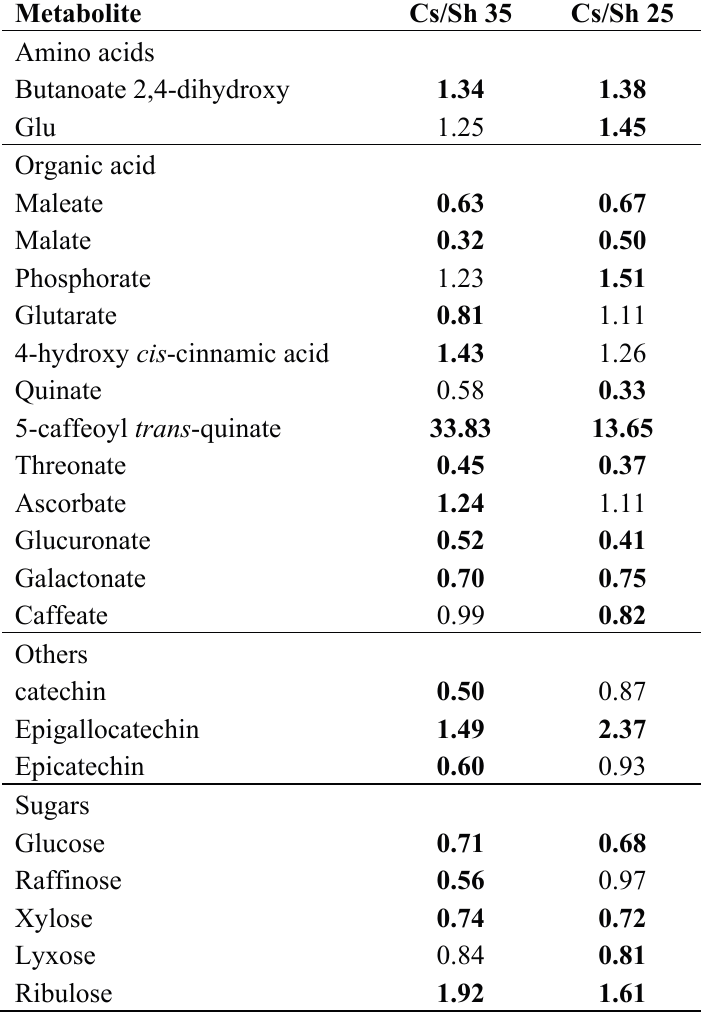
Table 2. Comparison of metabolites of Shiraz (Sh) vs. Cabernet Sauvignon (Cs) in the 35 and 25 °C treatments. Only metabolites that were significantly different between the cultivars in at least one of the treatments are presented. Values are the fold change of mean metabolic content ( n = 12) in Cs compared with in Sh. Bolded values represent significant differences between the treatments.